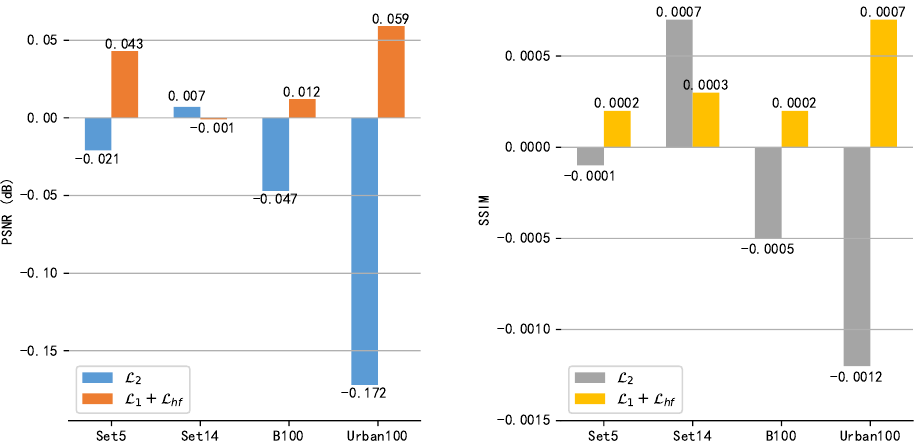
Figure 7. Comparison results of the performance difference between the three loss functions. We take PSNR/SSIM scores of L 1 as a baseline and the PSNR/SSIM scores of L 2 and the proposed L 1 + L hf are subtracted from it,